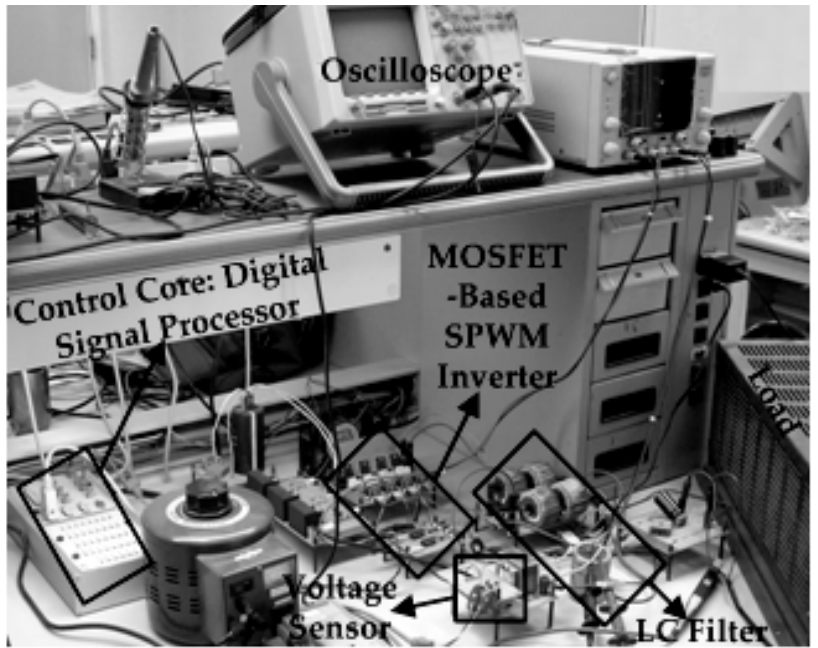
Figure 8. Circuits of hardware implementation.